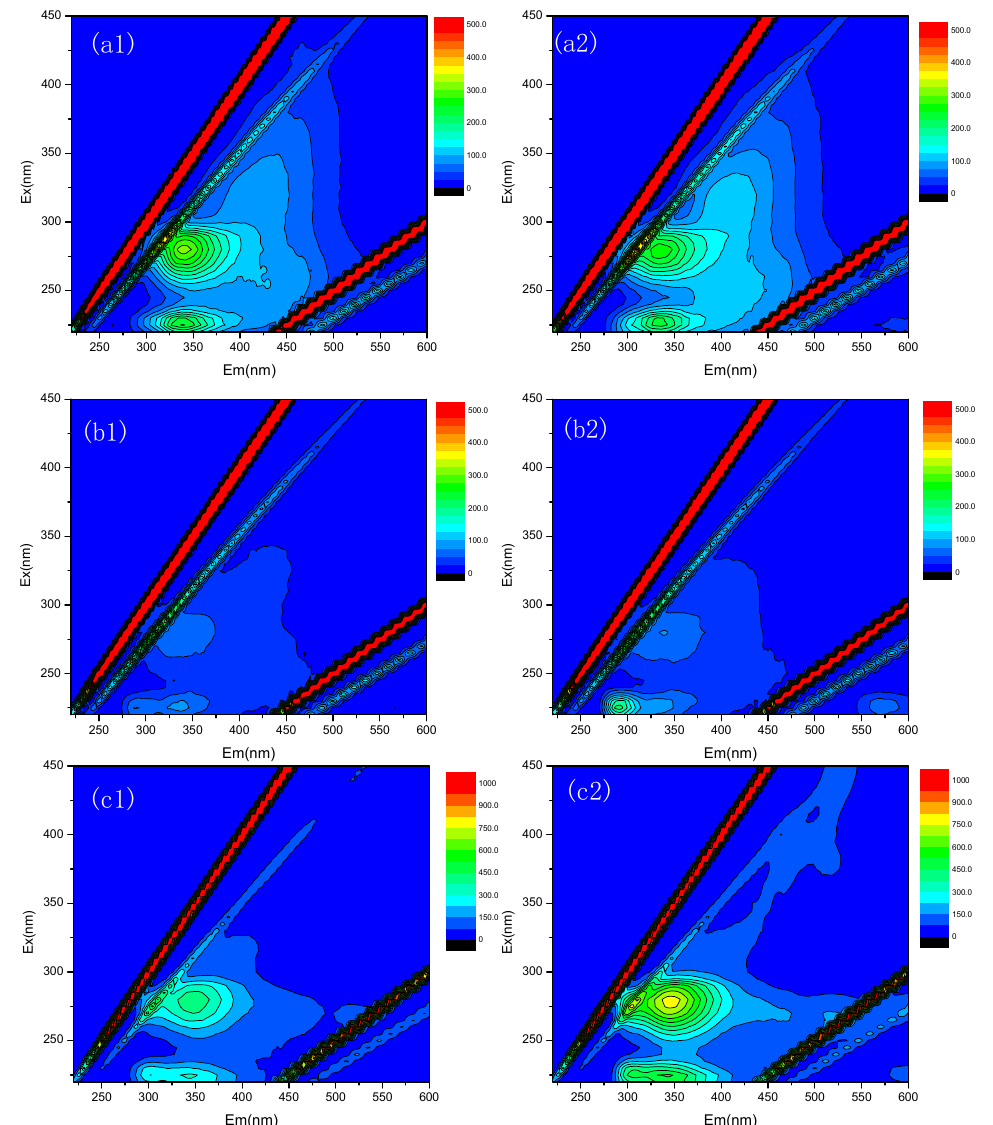
Figure 4. Excitation–emission matrix (EEM) spectra of SMP ( a ), loosely bound EPS (LB-EPS) ( b ) and tightly bound EPS (TB-EPS) ( c ) in the AnMBR at 35 °C (1) and the AnMBR at 25 °C (2).